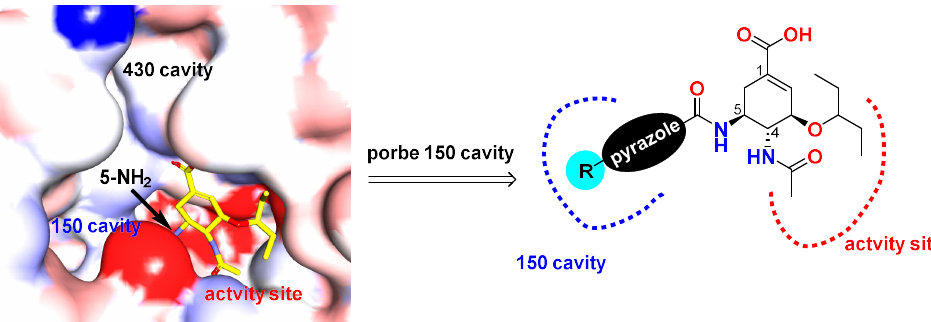
Figure 3. Design of the pyrazole-based C-5-NH 2 -acyl oseltamivir